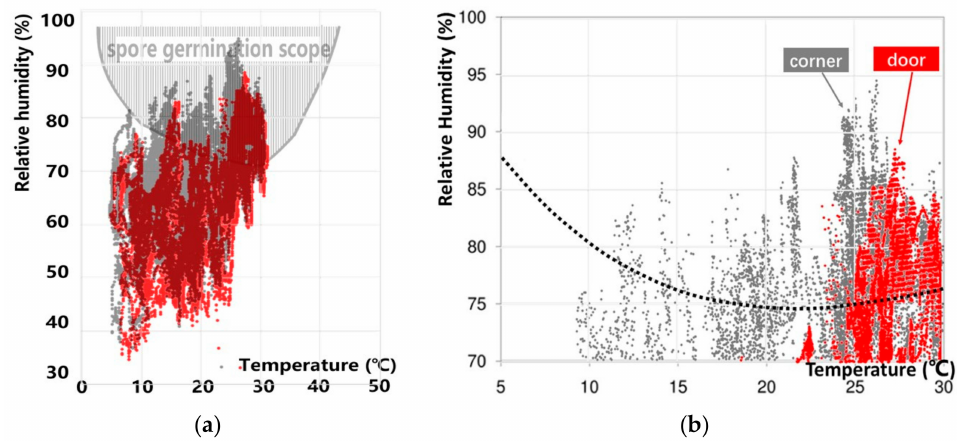
Figure 19. Mold growth risk evaluation of the indoor air at the door and the corner: ( a ) fungal spores’ germination scope (all the months); ( b ) Aspergillus penicilliodes’ growth risk evaluation during summer